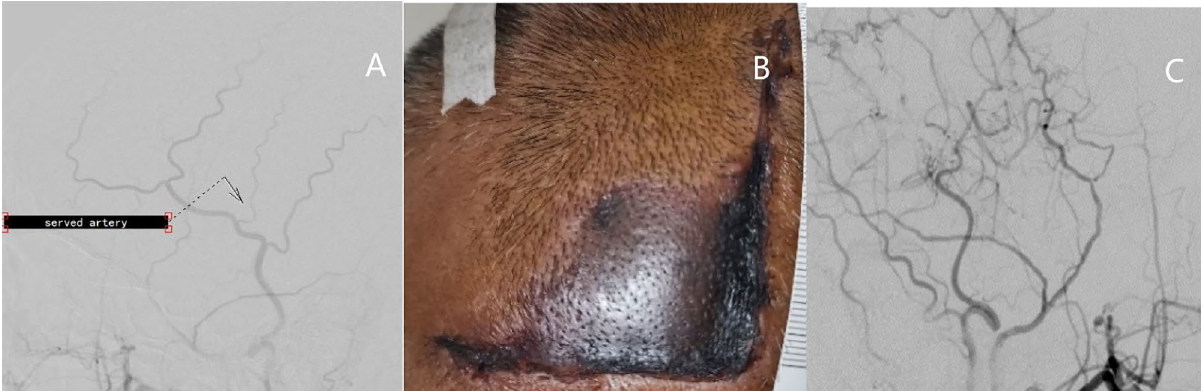
Figure 2. This group of pictures shows the temporal skin arteries and skin necrosis of a 57-year-old MMD male patient before and after the operation. ( A ) The preoperative DSA showed that there was a thick artery branch of Frontal branch of the left STA in the flap, which was cut during the bypass surgery. ( B ) Flap necrosis occurred in the postoperative patient. ( C ) 6 months after the flap restoring surgery, the peripheral artery compensated for the blood supply of the